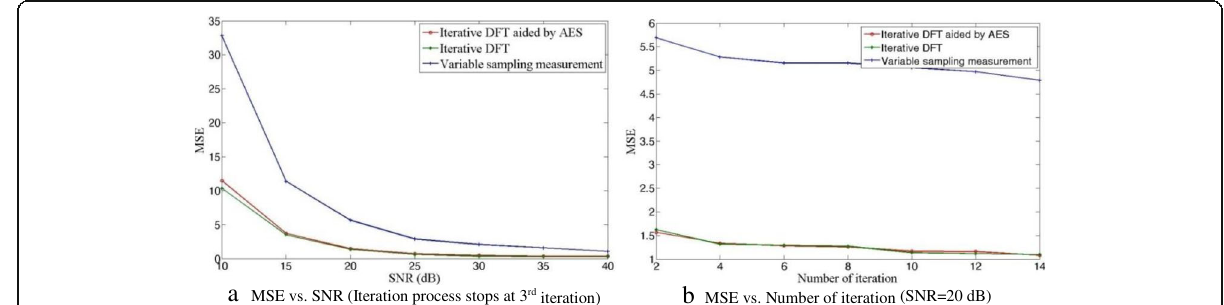
Fig. 9 Performance comparison of three algorithms in scenario 1 (in the first algorithm (red)), initial frequency estimation of DFT iteration is aided by AES, in which P = Q =7. In the second algorithm (green), initial frequency for DFT iteration is set to be 60Hz in every cycle. The third one is from paper [31])